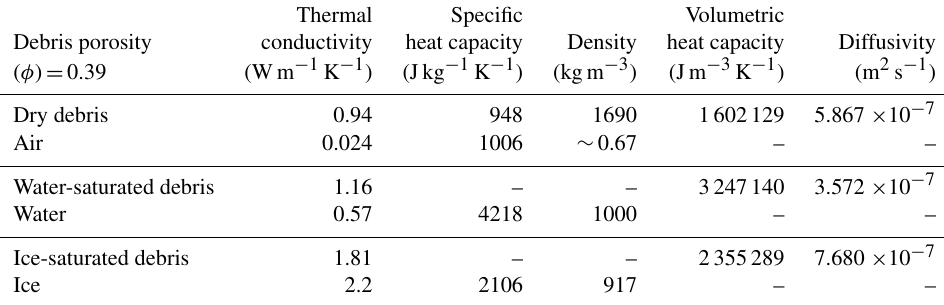
Table 1. Thermally relevant properties of dry debris, in which interstitial pore spaces are filled with air, water-saturated debris, and ice- saturated debris of porosity ( φ ) = 0.39. References and calculation details are given in a complementary table in the Supplement (Table S1). Air density is a function of elevation, air temperature, and air moisture. Thermal conductivity presented by Reid and Brock (2010) is an “effective” value, from measurements, that is a function of debris’ unspecified porosity and any moisture content at the time of measurement (Collier et al., 2016). Brock et al. (2010) used a published value of specific heat (948Jkg − 1 K − 1 ). We assume that these values of thermal conductivity and heat capacity (here listed for “dry debris”) are valid for dry debris on West Changri Nup glacier and subsequently perform sensitivity tests. More details about this assumption and its implications can be found in the Discussion.